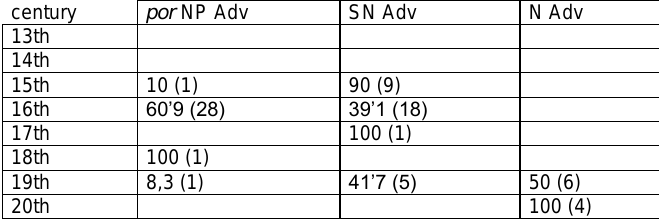
Table 6. Frequency of camino adelante ‘along the road’